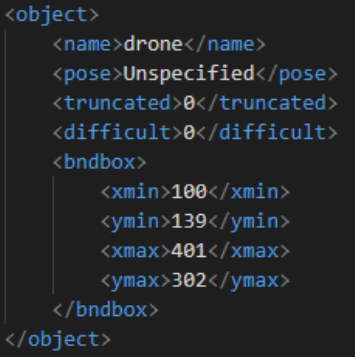
Figure 7. Dataset annotation example.